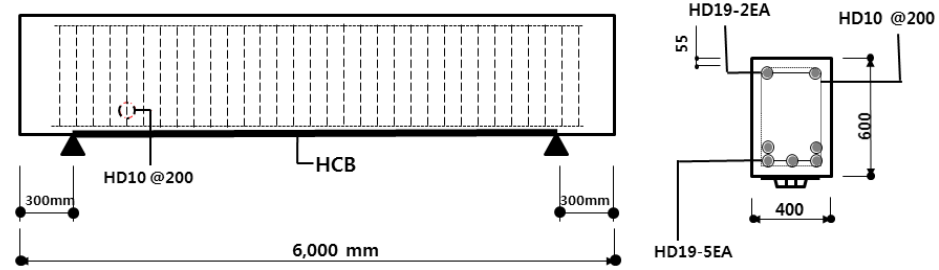
Figure 2. Details of the HCB-strengthened reinforced concrete (RC) beam specimen.